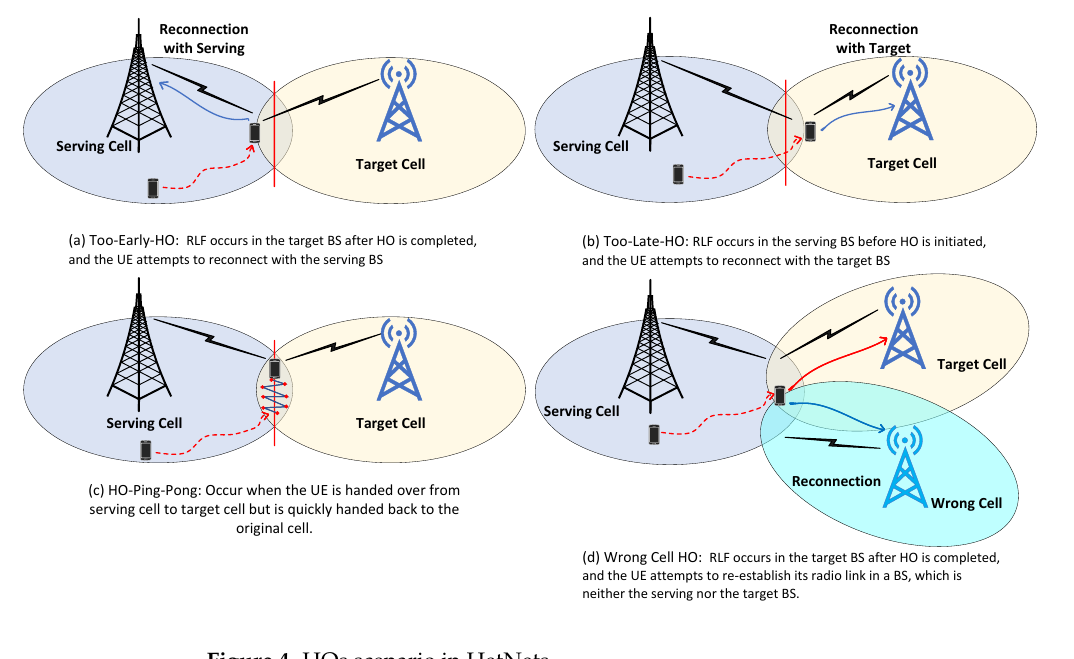
Figure 4. HOs scenario in HetNets.